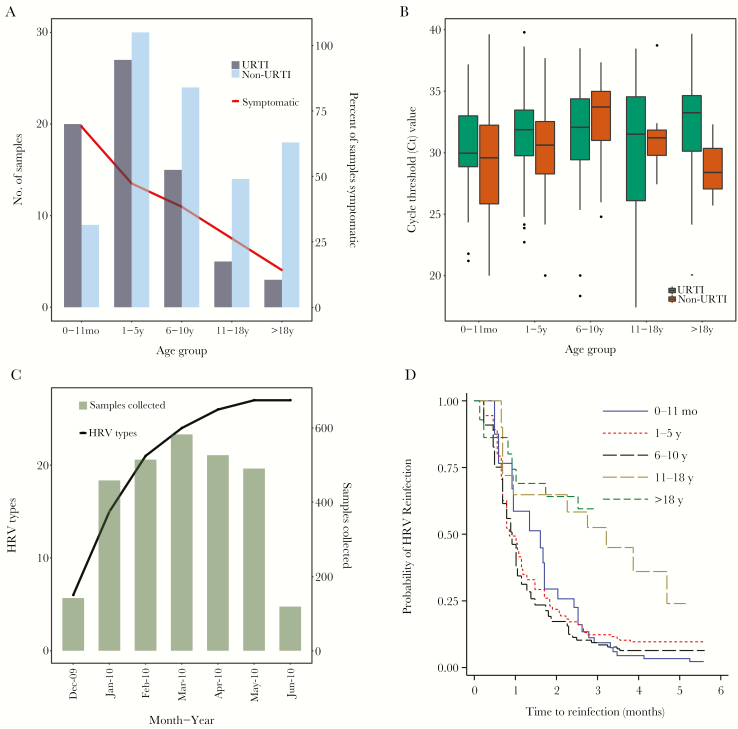
Surveillance in 5 households in 2009–2010 in coastal Kenya. (A) Human rhinovirus (HRV)-positive samples by age groups and by symptomatic status, with proportions per group shown as percentage. (B) box plots of real-time reverse-transcription polymerase chain reaction cycle threshold (Ct) values across the various age groups, by symptom status. (C) cumulative number of the different HRV types observed over the study period in all the 5 households (line), comparing with monthly sample collection values (bars). (D) Kaplan-Meier plot showing survival estimates of time to HRV reinfection, stratified into 5 age groups. Abbreviations: URTI, upper respiratory tract infection